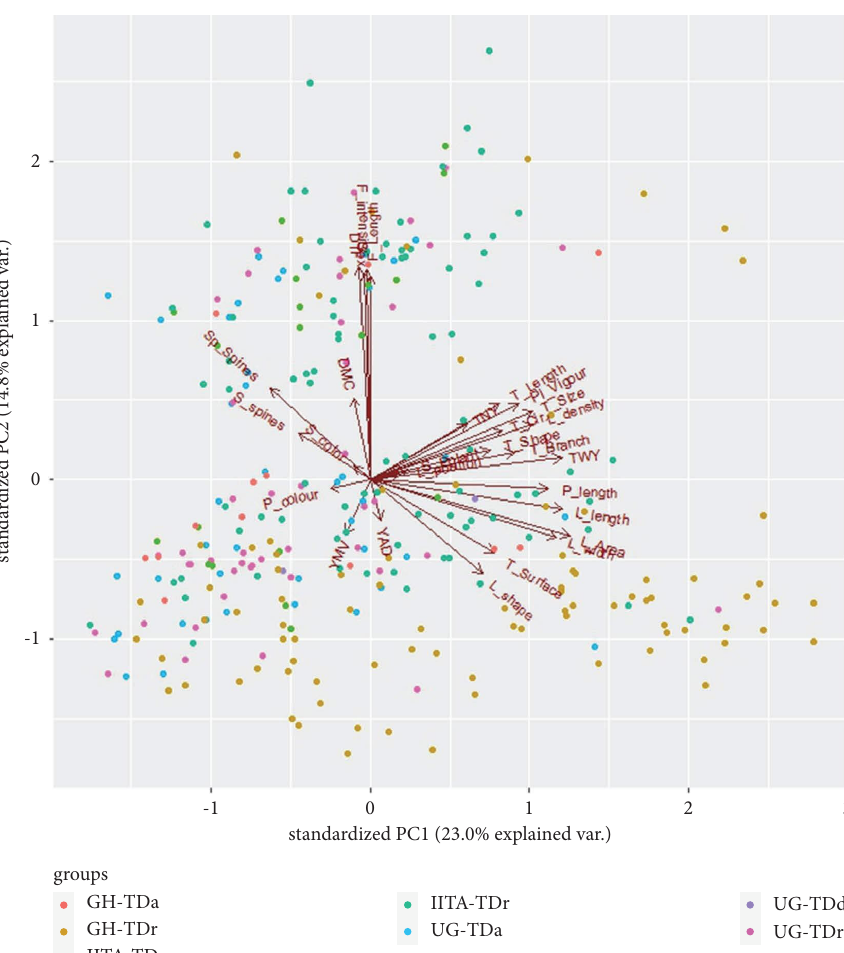
Figure 5: Te two-dimensional plot of the frst two principal components (PC1 and